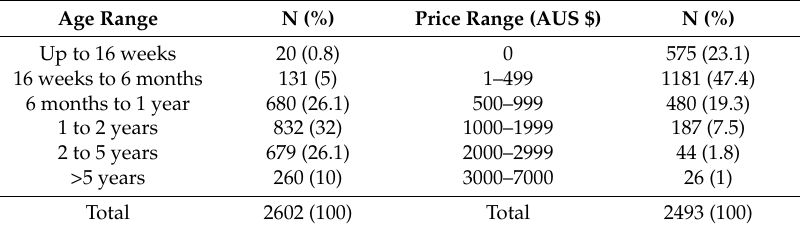
Table 2. Age and price categories of dogs relinquished on Gumtree from 8 to 24 February 2016. Age Range N (%) Price Range (AUS $) N (%) Up to 16 weeks 20 (0.8)